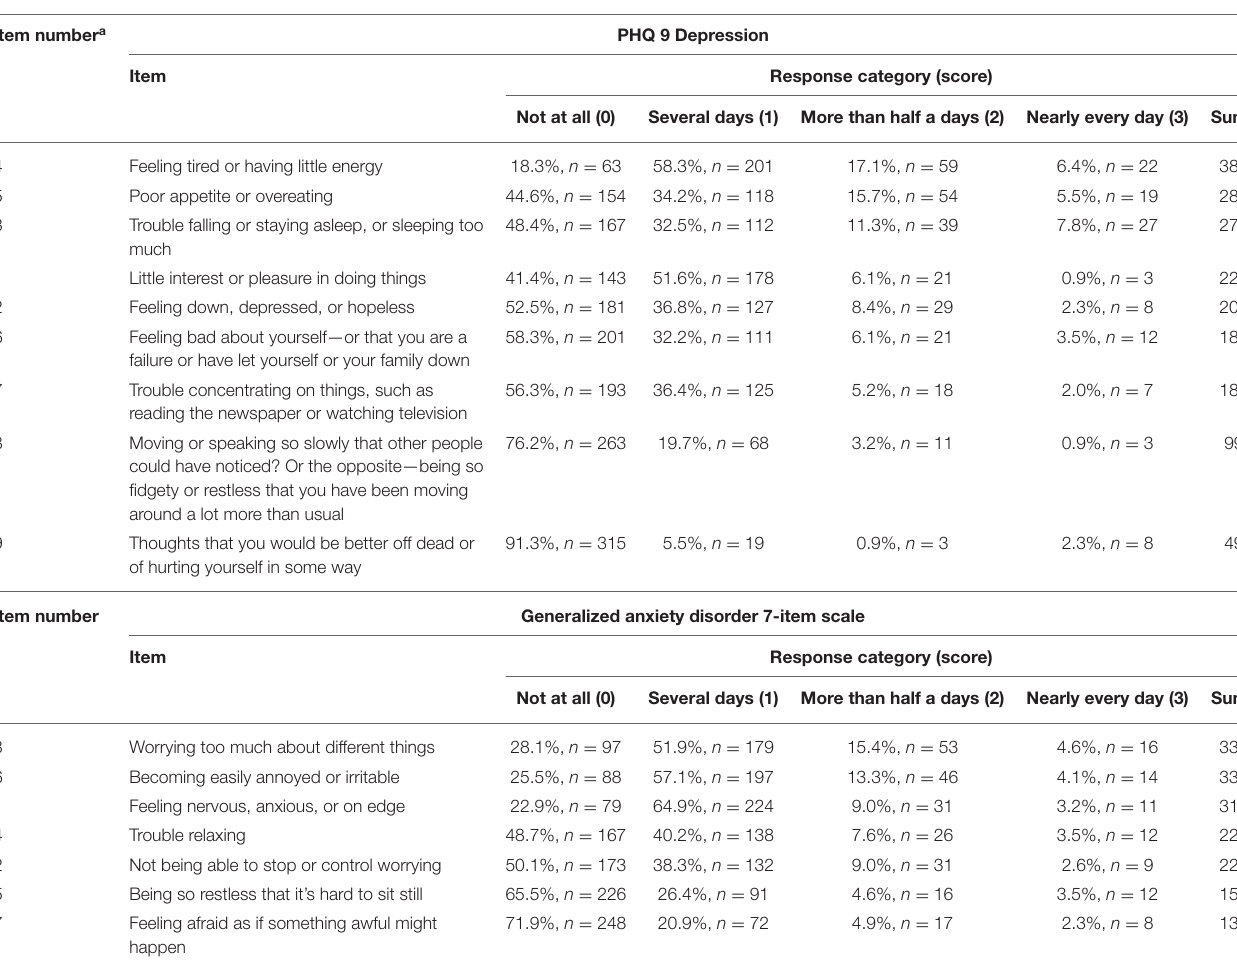
TABLE 5 | Symptoms of depression and anxiety in total and in association to the three additional